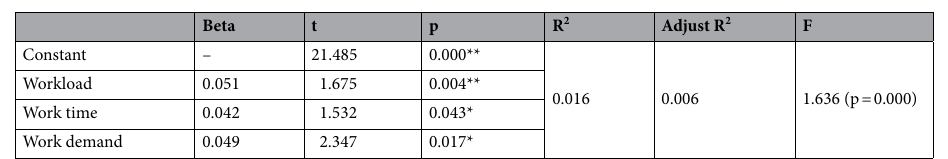
Table 7. Ridge regression analysis results of workload and its dimensions on miners’ unsafe state. Beta represents standardized regression coefficient. t represents a test value for each independent variable one by one. p represents the significance value. *Represents a significant level at p < 0.05. **Represents a significant level at p < 0.01. R 2 is the square of the multivariate correlation coefficient. F represents the analysis of variance test